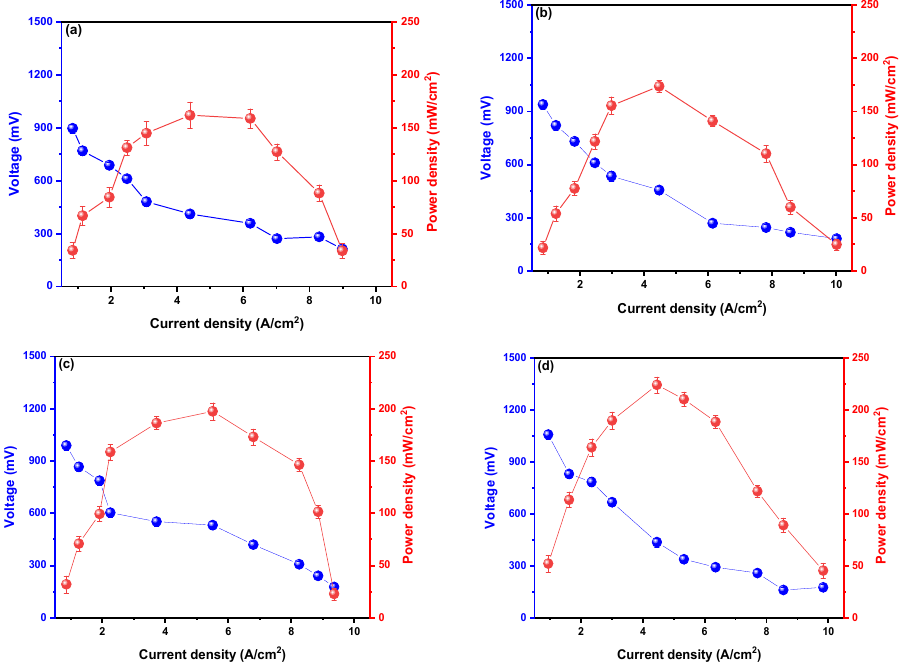
Figure 3. Values of the power densities as a function of the current density of the microbial fuel cells at ( a ) 0-target, ( b ) 5, ( c ) 10, and ( d ) 20% sucrose.